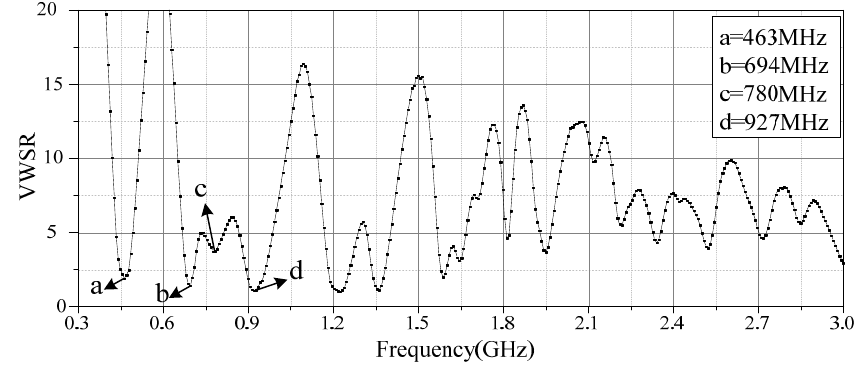
Figure 11. The measured VSWR of the antenna.